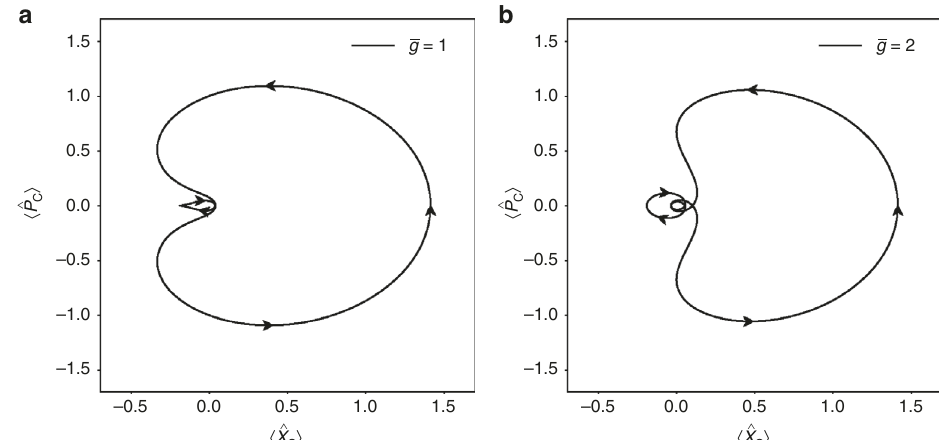
and momentum h ^ P quadratures of the cavity state ρ C that starts as a coherent state c i c i